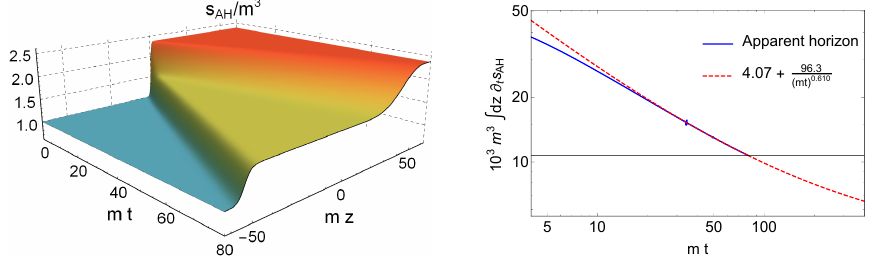
Figure 15: We show the entropy density as determined from the area of the apparent horizon (left) as well as time derivative of the spatial integral (right). The entropy production is to a good approximation given by the sum of the entropy production of the shock and rarefaction waves as derived in Fig. 14, and also the late time value (4.07, from the red dashed fit on the right) matches well with the hydrodynamic result shown in Fig. 14